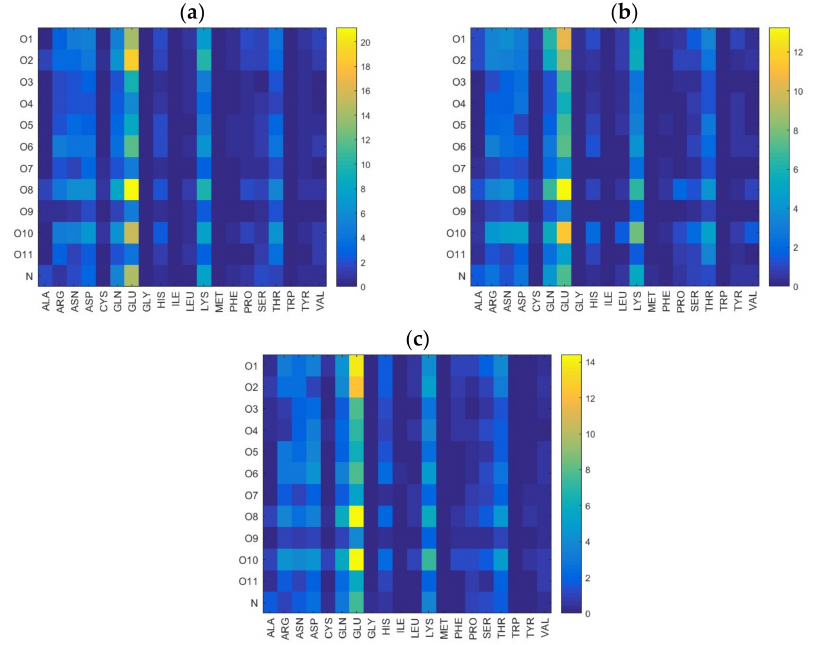
Figure 8. Water bridge distribution between different oxygen classes in HA and different amino acids in HSA. Data were obtained in solutions containing ( a ) Na + , ( b ) Ca 2+ , ( c ) Mg 2+ . In all cases, Cl − was the